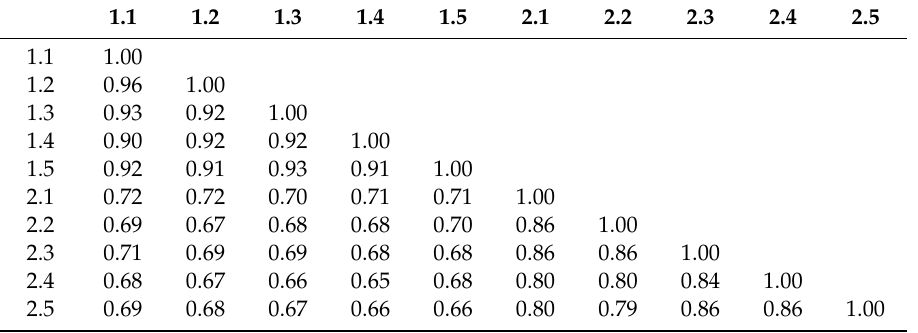
Figure 3. The dendrogram constructed from 25 primers by the NTSYSpc 2.10 program showing genetic relationships of the hybrid catfish samples between the reference catfish (1.1 – 1.5) and landfill catfish (2.1 – 2.5).